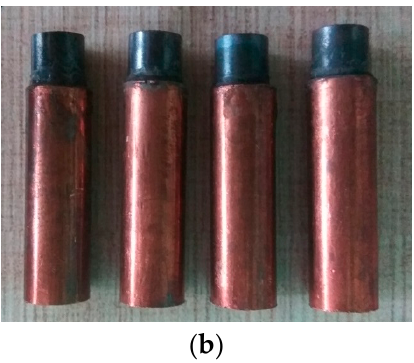
Figure 2. ( a ) Sintering cycle used in this study; ( b ) brazed Cu–TiC tools.